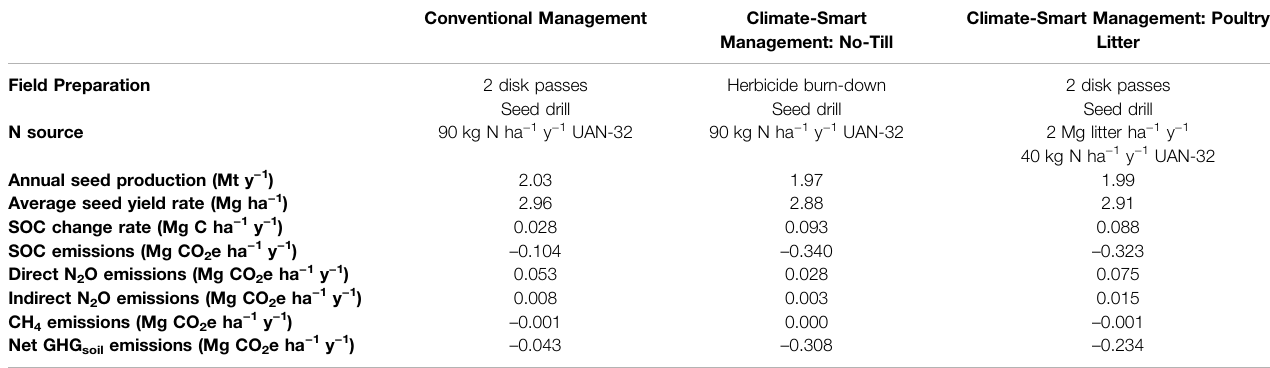
TABLE2| Summaryofregional-scalesimulationresultsfordifferentcarinatamanagementscenarios.AllsoilGHGvaluesareevaluatedrelativetothecontinuedbusiness-as- usual cotton – cotton – peanut reference